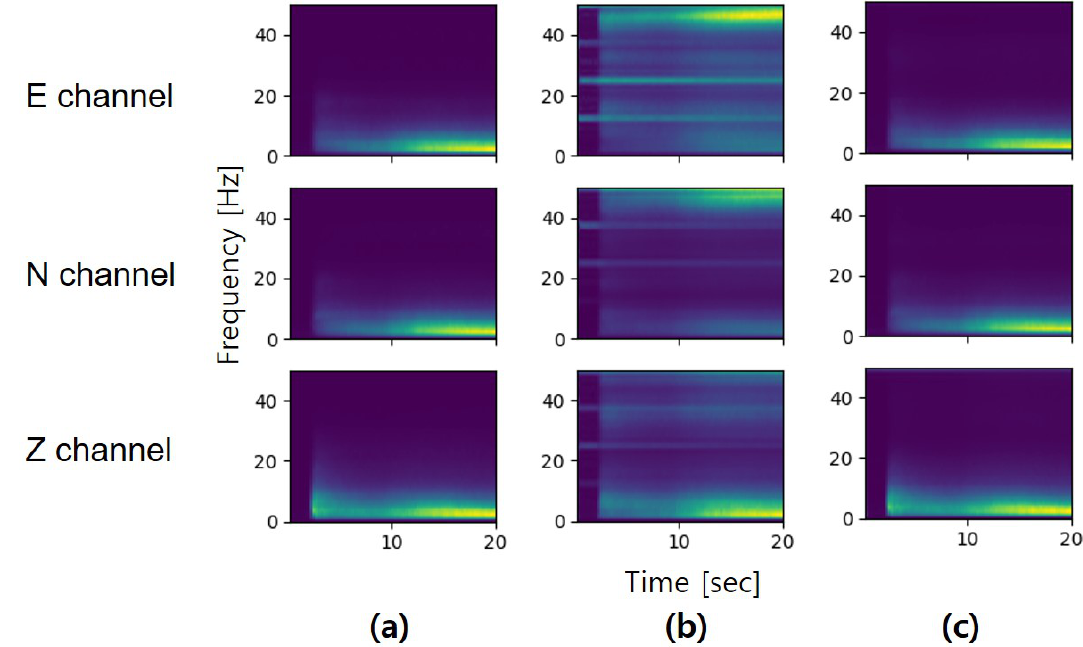
Figure 10. Mean of spectrogram obtained by: ( a ) real dataset, ( b ) synthetic dataset (w/o feature extractor) and ( c ) synthetic dataset (with feature